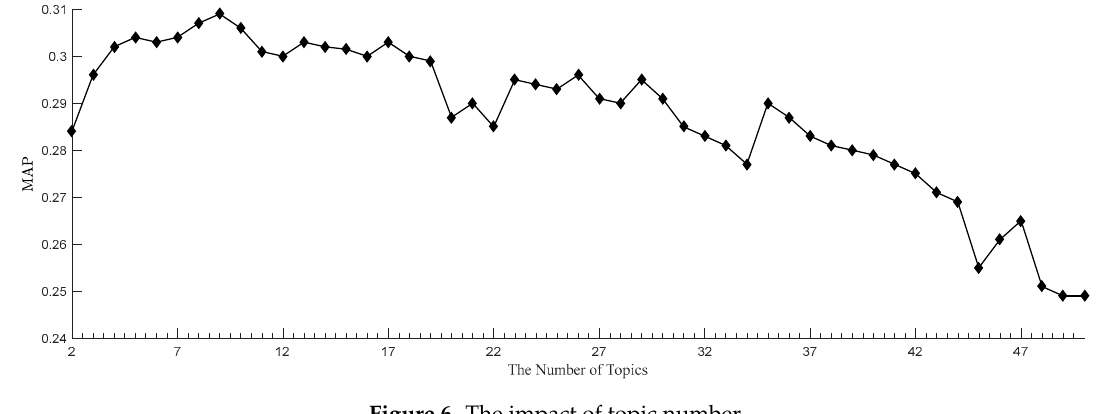
Table 3. The performance of eliminating different types of information (results indicated as (mean ± standard deviation)).